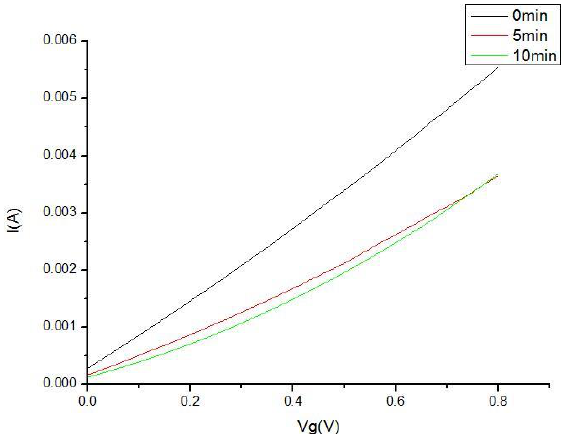
Figure 9. I − V curves corresponding to the initial signal, the AChE functionalizationsignal and the isocarbophos signal.